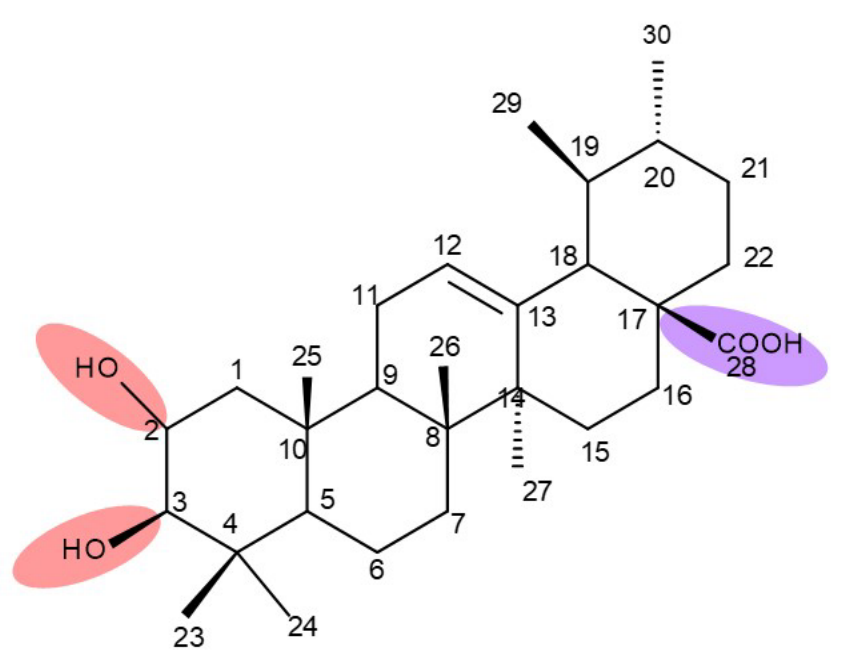
Figure 8. Frequent targets for the derivatization of maslinic acid.